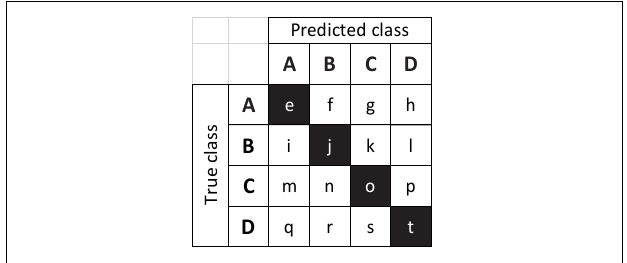
FIGURE 6 | Example 4-class confusion matrix, with classes A–D. Correct predictions are on the main diagonal (e, j, o, t, shown shaded) and off-diagonal cells are the misclassifications. Sums of off-diagonal elements along a row (column) are the source (sink) misclassifications for the class.